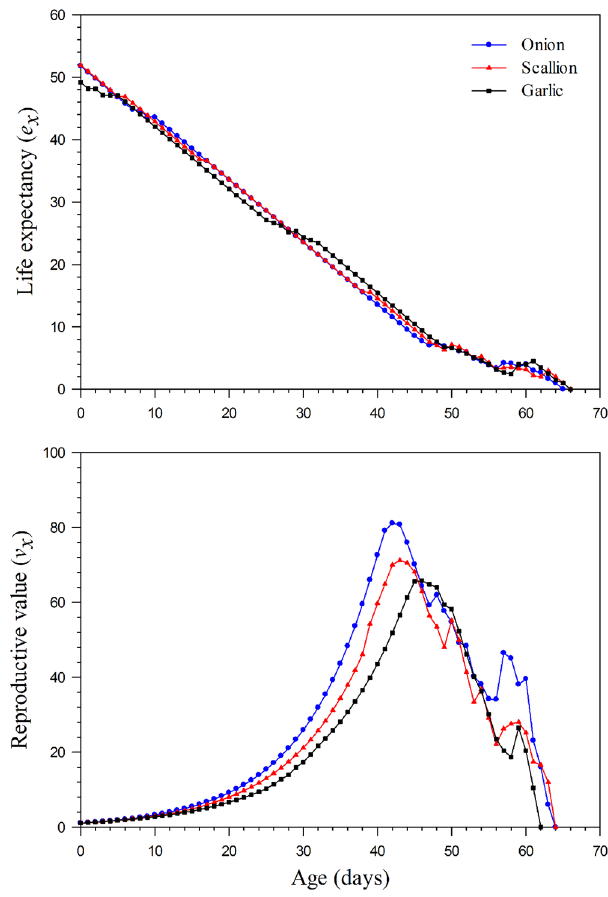
Figure 4. The age-specific life expectancy and reproductive value of Delia antiqua on different host plants of group reared method. Upper: The age-specific life expectancy; Below: The age-specific reproductive